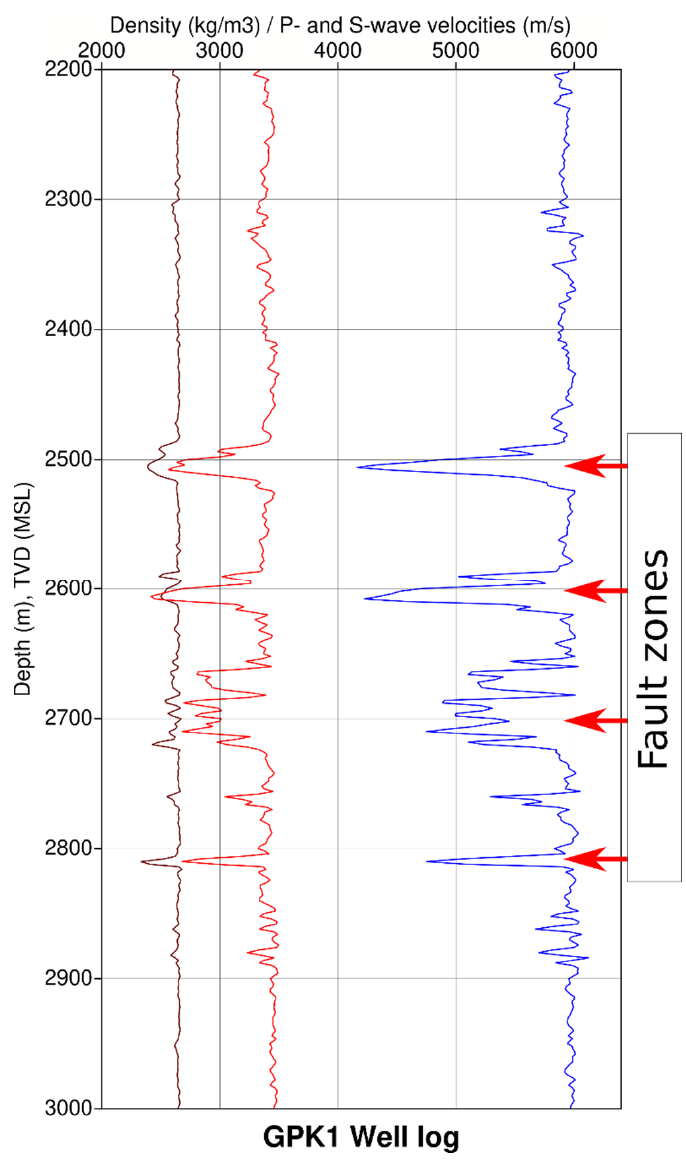
Figure 3. Middle part of the borehole logs for GPK1 (granite) where the blue profile is the P-wave velocity, the red profile is the S-wave velocity, and the brown profile is the density values. The red arrows show the location of some interpreted fault zones. A good correlation is observed between P- and S-wave velocities and density (especially in the granites). These borehole data are measured on a well crossing the dipping faults. The apparent vertical thickness of these fault zones varies between 15 and 80 m. If we consider a fault dip of 75 ◦ , we found that their real thickness varies between 5 and 25